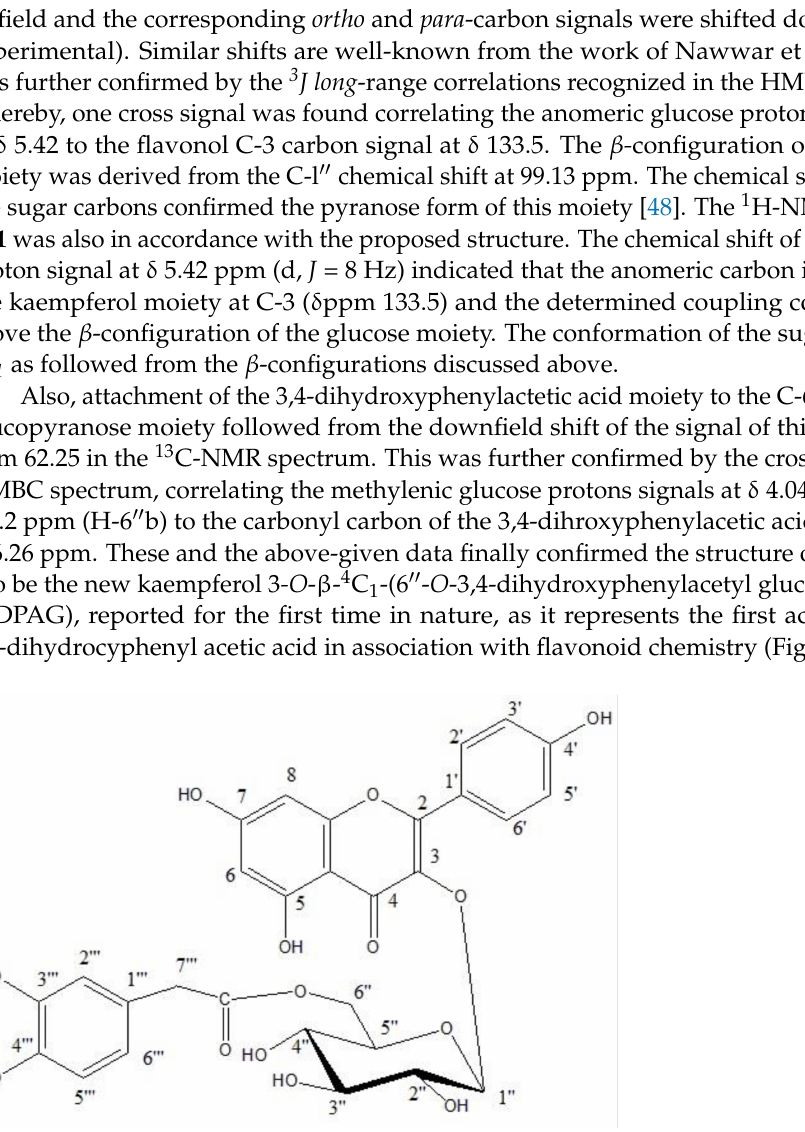
Figure 1. kaempferol 3- O- β - 4 C 1 -(6 (cid:48)(cid:48) - O -3,4-dihydroxyphenylacetyl